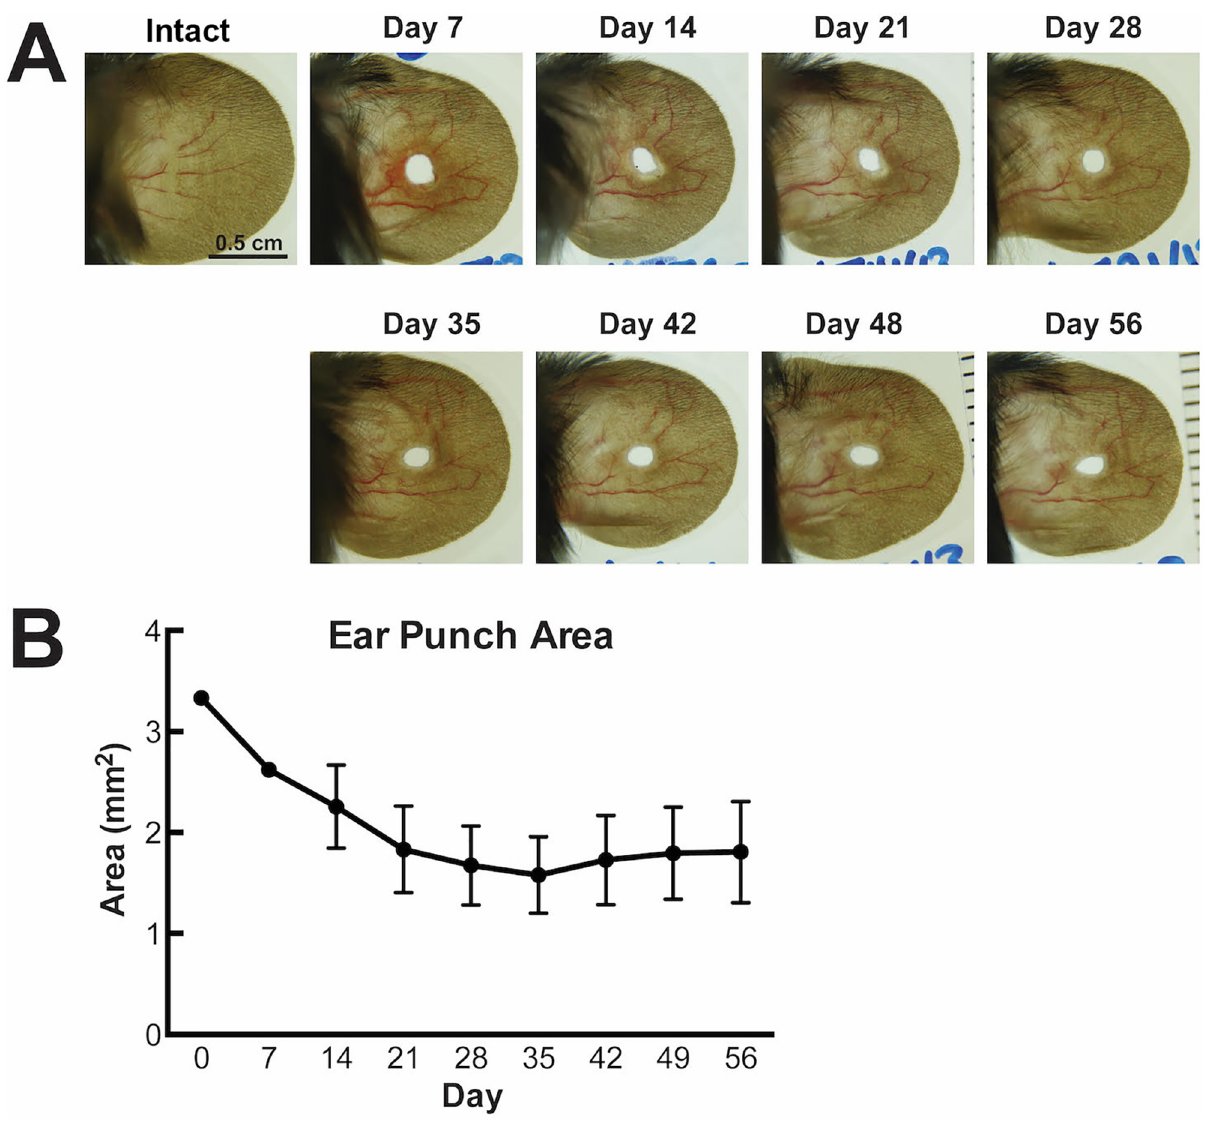
Fig 1. Normal wound healing of a 2mm critical size defect in the murine ear. A) representative photographs of the murine ear prior to wounding (intact), and of healing at time points up to 8 weeks after a punch wound. B) Wound area over time. Each point represents the mean wound area (mm 2 ) ± SEM, n =